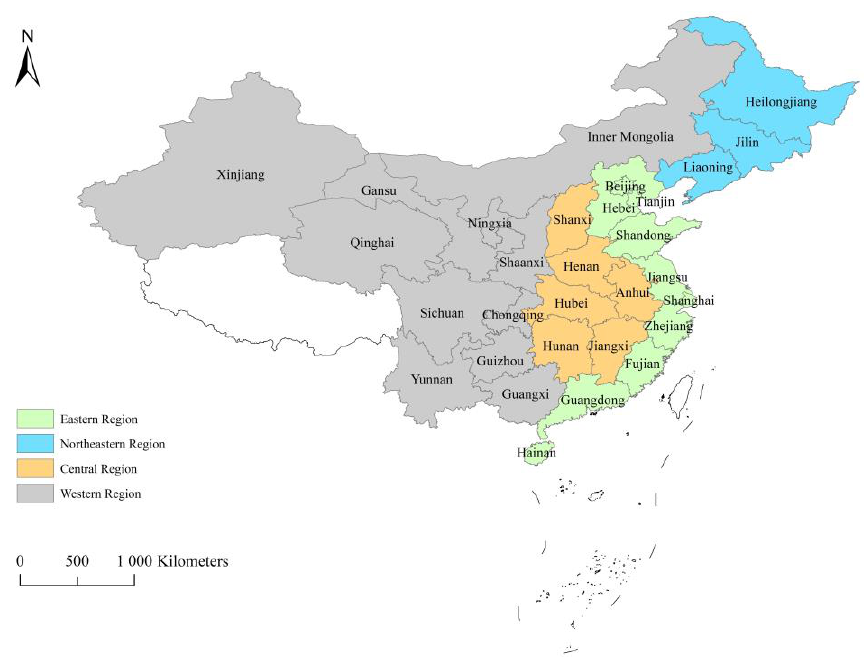
Figure 1. Geographical distribution of the four regions in China.